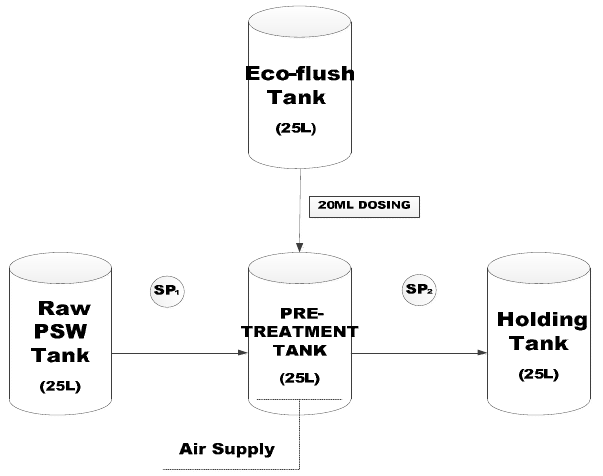
Figure 3. Pre-treatment Experimental Set-up (SP = sample point).